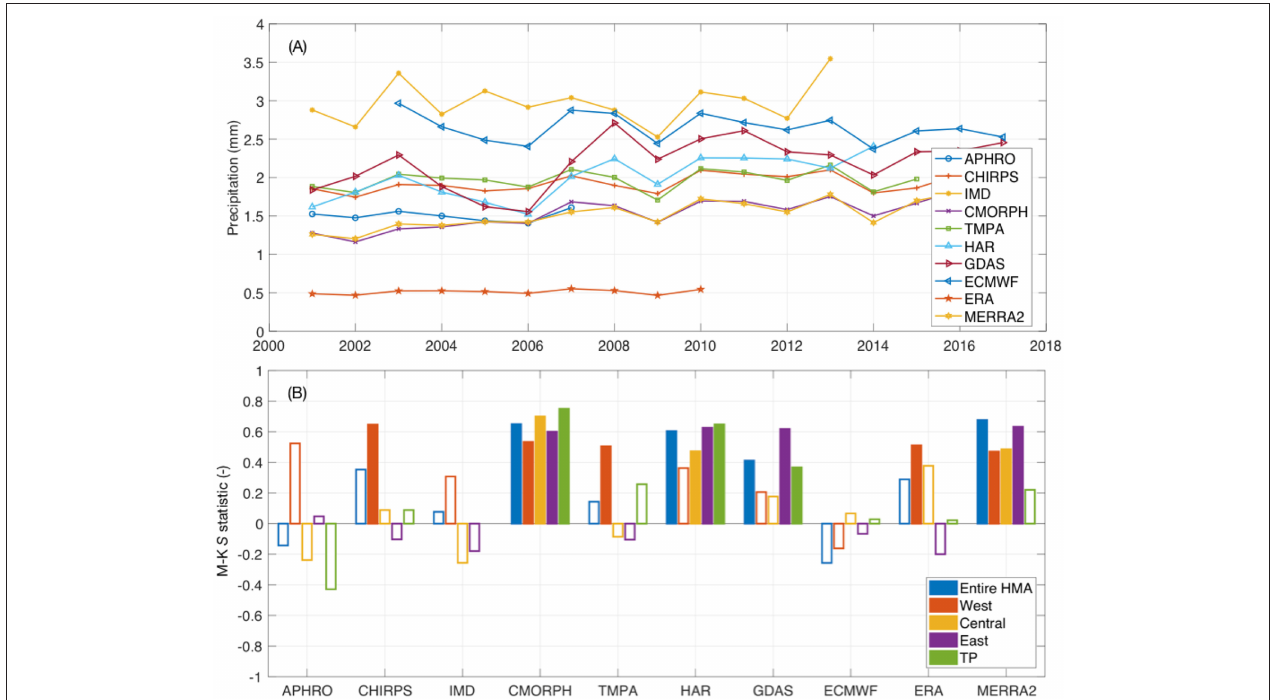
FIGURE 8 | Time series of domain-averaged mean annual precipitation (A) , and estimates of the Mann Kendall S -statistic (B) for the entire HMA and four sub-regions ( Figure 1 ). The statistically significant trends are shown with filled boxes.